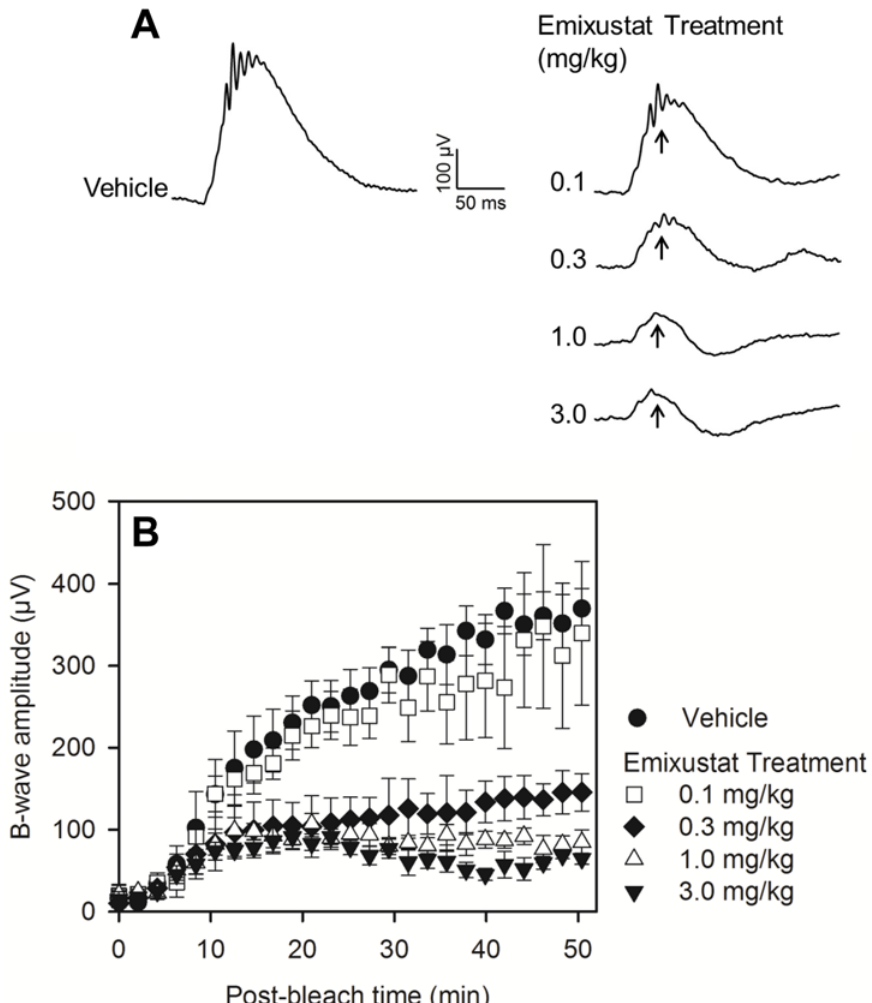
Fig 3. Pharmacodynamic Effect of Emixustat on Rod Function. The recovery of rod photoreceptor function following a photobleach was measured by ERG. Mice were treated with varied doses of emixustat (n = 4/dose group), or vehicle (n = 4/group), and ERG responses were recorded every 2 minutes for 50 minutes using a light stimulus 0.01 cd * s/m 2 . Panel A shows representative ERG waveforms in vehicle- and emixustat-treated mice. Arrows in panel A indicate the b-wave amplitude peaks which are plotted as a function of recovery time after photobleach in panel B. B-wave response amplitudes ( μ V), at each corresponding time point of recovery, are shown as mean values ± SEMfor each of the treatment groups (panel B). Emixustat treatment caused a dose-dependent suppression of b-wave response amplitudes. The dose required for half-maximal suppression of ERG b-wave recovery was determined to be 0.21 mg/kg.